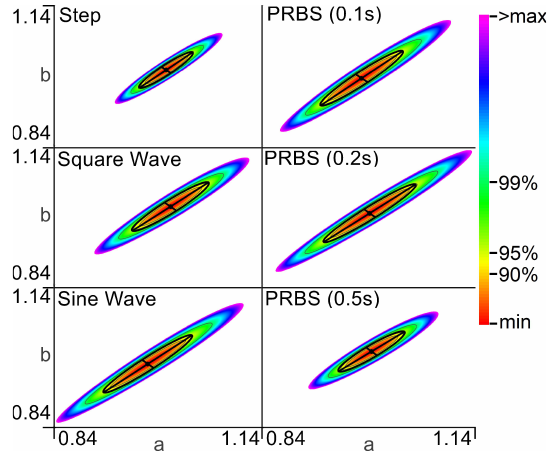
Figure 13: PL2 heat-maps with 90%, 95% and 99% confidence iso-lines, for all six data-sets, with added 95% confidence ellipses (thick line), computed from the Hessian of (cid:96) ( θ ), for comparison.